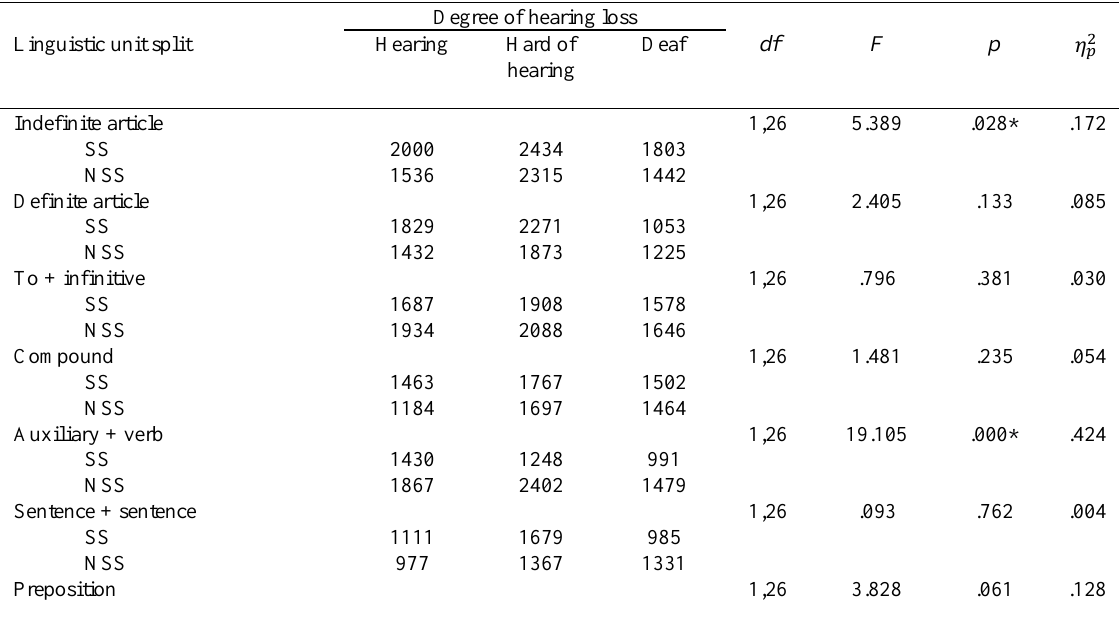
Table 9. Dwell Time by linguistic unit and segmentation